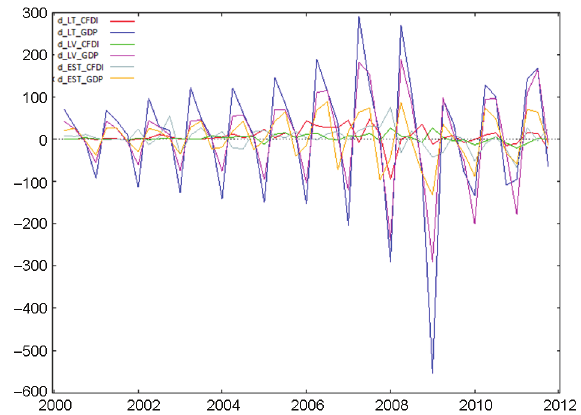
Fig. 10. The chart of the first-order integration time series for CFDI and the construction’s contribution to GDP in Lithuania, Latvia and